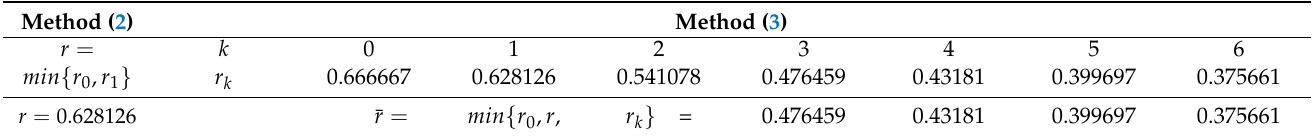
Table 2. Estimates for Example 2.